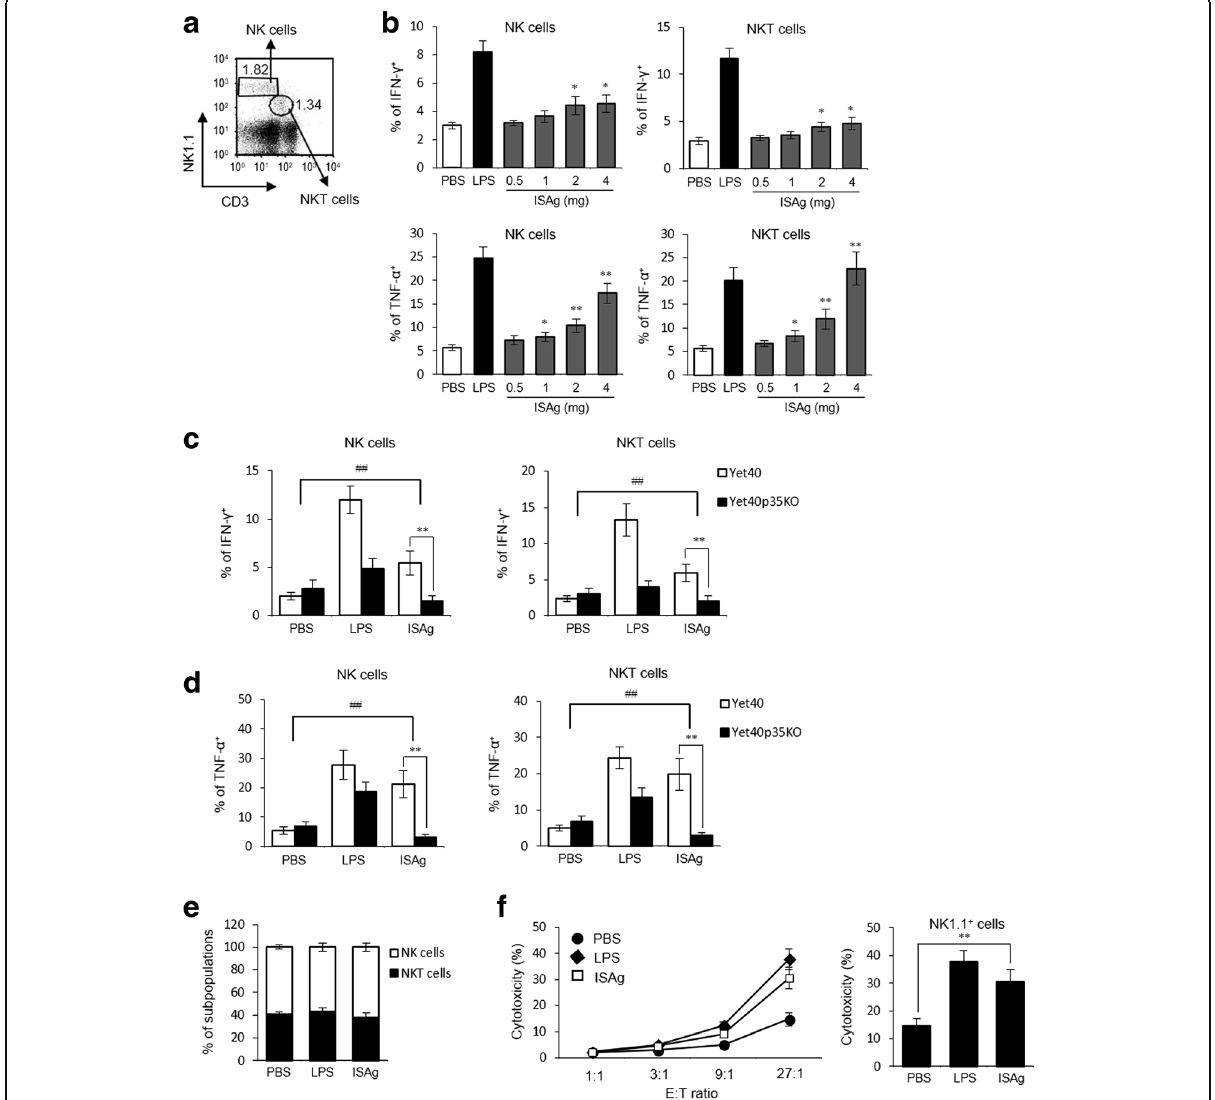
Fig. 6 ISAg activated NK receptor-expressing innate immune cells via DC-derived IL-12. a The percentages of NK (NK1.1 + CD3 − ) and NKT cells (NK1.1 + CD3 + ) among the total splenocytes from Yet40 B6 mice were plotted. b Yet40 B6 mice were treated via the oral route with ISAg (0.5, 1, 2, or 4 mg/injection) or PBS three times per week for 4 weeks. As a positive control, mice were injected (i.p.) with LPS (2 μ g) once per week for 4 weeks. Intracellular productions of IFN- γ and TNF- α were analyzed in NK and NKT cells. c , d Yet40 and Yet40p35KO mice were treated via the oral route with ISAg (4 mg/injection) or PBS three times per week for 4 weeks; intracellular production of ( c ) IFN- γ and ( d ) TNF- α were then analyzed in NK and NKT cells. ( e ) NK1.1 + cells were isolated from total splenocytes of WT B6 mice treated with ISAg (4 mg/injection), PBS, or LPS [2 μ g/injection (i.p.)]. The percentages of NK and NKT cells among the purified NK1.1 + cells were measured using flow cytometry. f Purified NK1.1 + cells were co-cultured with CFSE-labeled B16 tumor cells (2 × 10 4 ) at the indicated E:T ratios. After 10 h of co-culture, cytotoxicity was evaluated by calculating the percentage of 7-AAD + (dead) cells, compared with the CFSE + target cells. The mean±standard deviation values are presented (n=3 per group; Student ’ s t-test; * P <0.05, ** P <0.01). Two-way ANOVA (genotype × treatment) revealed there was an interaction between these two factors ( ## P